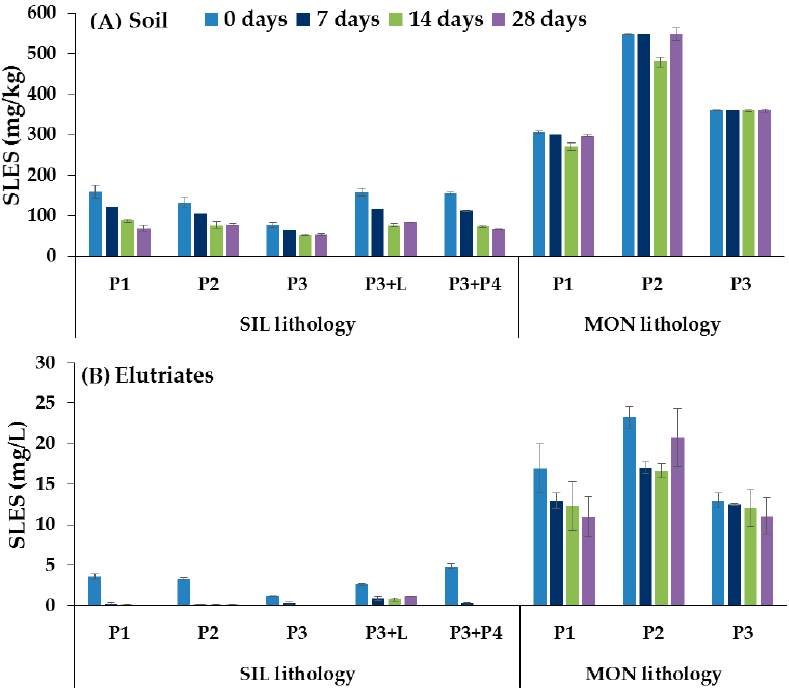
Figure 1. Average values of SLES concentration in the various SIL and MON mesocosm conditions (soils conditioned with P1,2,3,4 and P3 + P4) at the different sampling times (0, 7, 14 and 28 days). ( A ) in soil (mg/kg); ( B ) in elutriates (mg/L). The vertical bars represent standard errors. SIL: sandy- silty-clay soil; MON: gravel in a sandy-silty soil. P1, P2, P3, P4: foaming agent products.